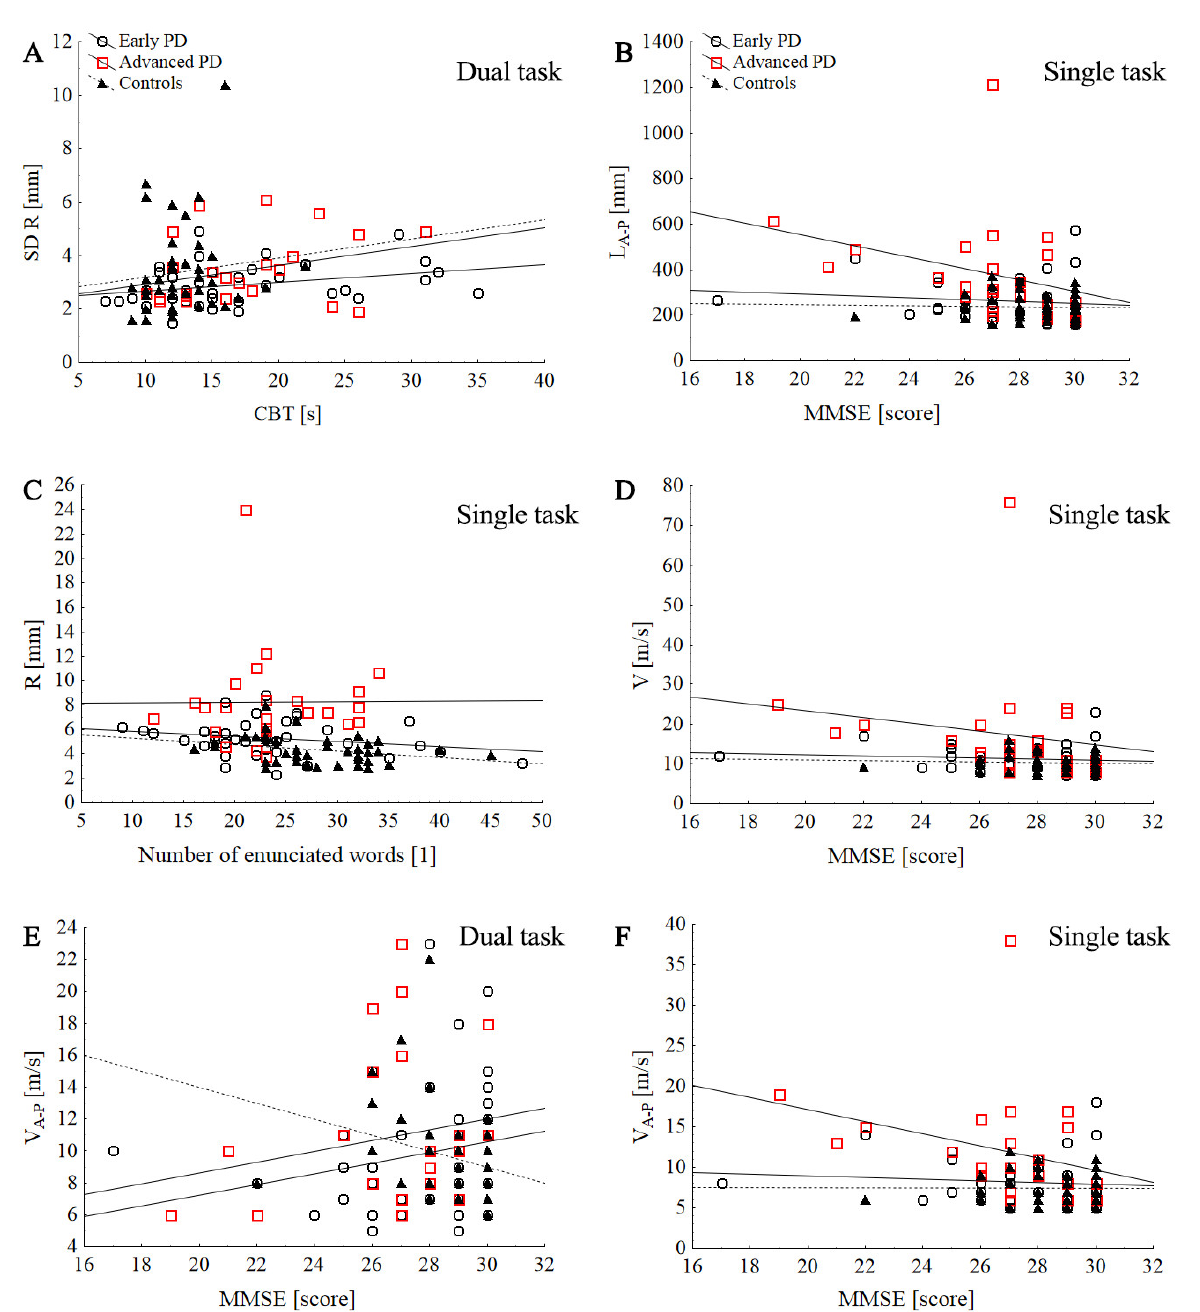
Figure 4. Scatter plot of the association between the stabilographic parameters with counting-backward test (CBT) and MMSE score in control and PD groups during single and dual tasks: SD R dual task (A), L A-P single task (B), R single task (C), V single task (D), V A-P dual task (E), V A-P single task (F).